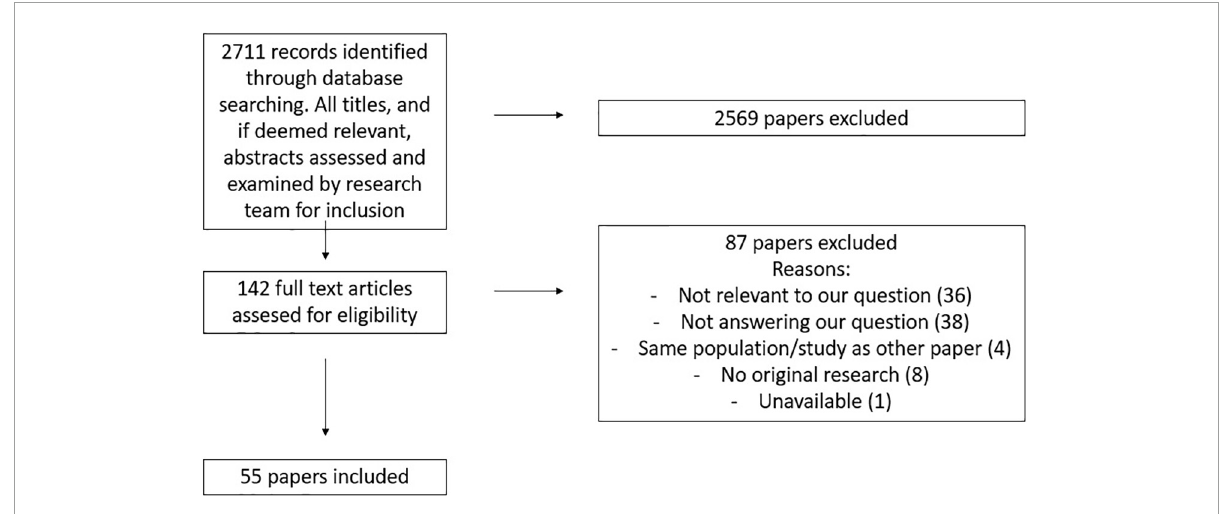
FIGURE1 Literature selection